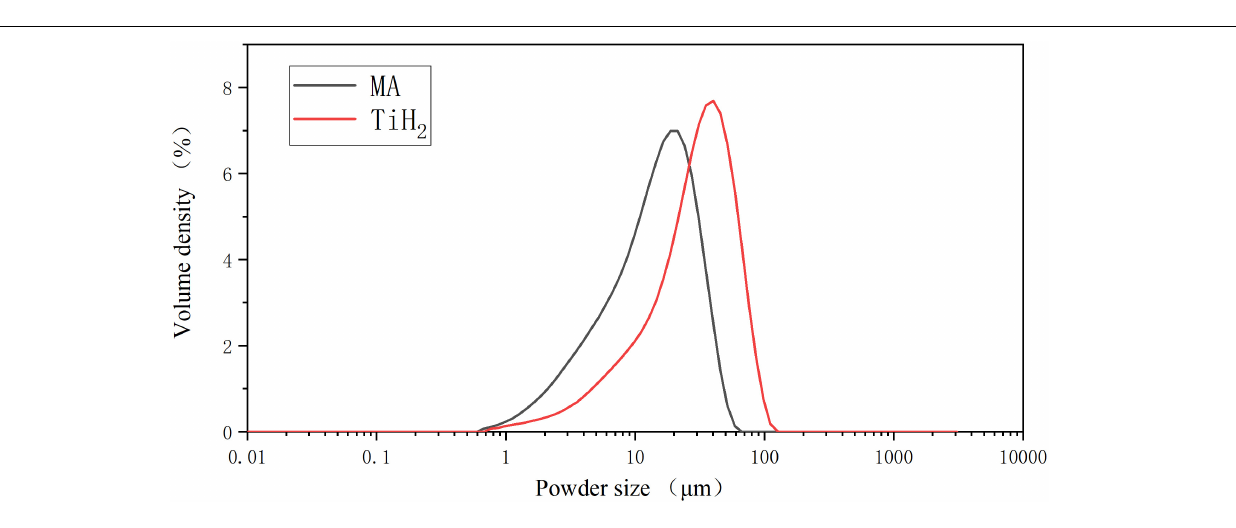
FIGURE 2 | Size distribution curve of TiH 2 and master alloy (MA)